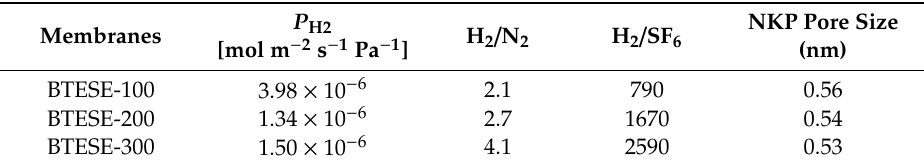
Table 3. Gas permeation performances and Normalized Knudsen-based permeance (NKP) pore sizes of the BTESE